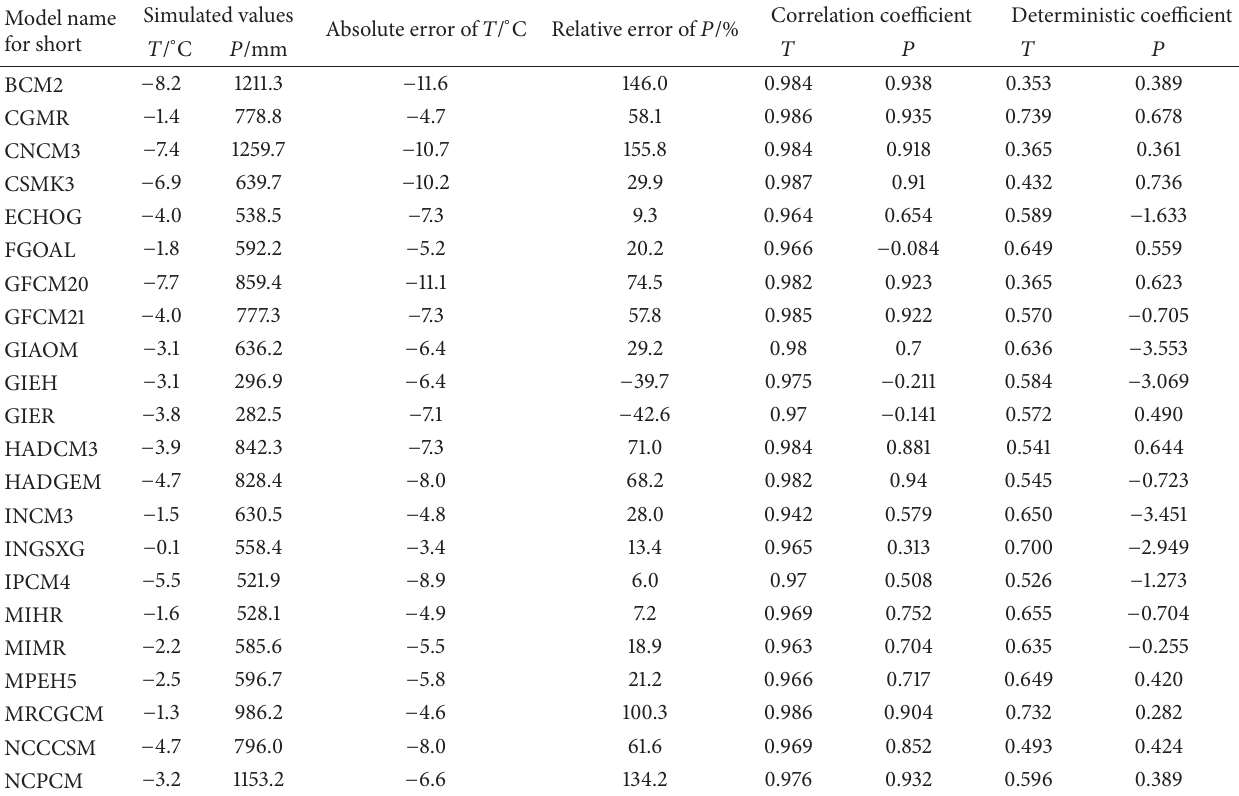
Table 2: Comparison of temperature and precipitation between simulations of climate models and observation.